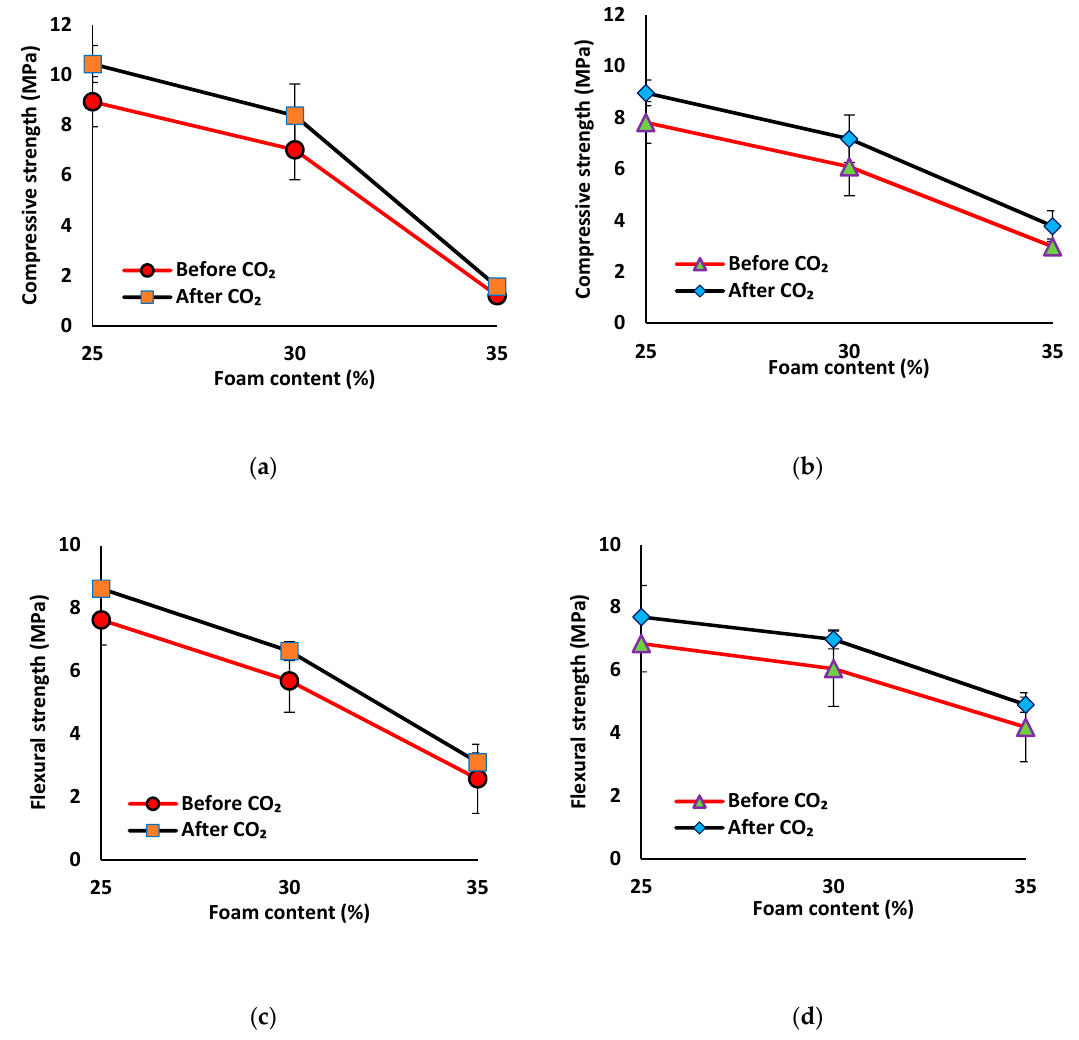
Figure 13. Impacts of the carbonation on the compressive strength of mix compositions: ( a ) SW50/GW10; ( b ) SW30/GW30; and on the flexural strength of mix compositions: ( c ) SW50/GW10; ( d ) SW30/GW30.